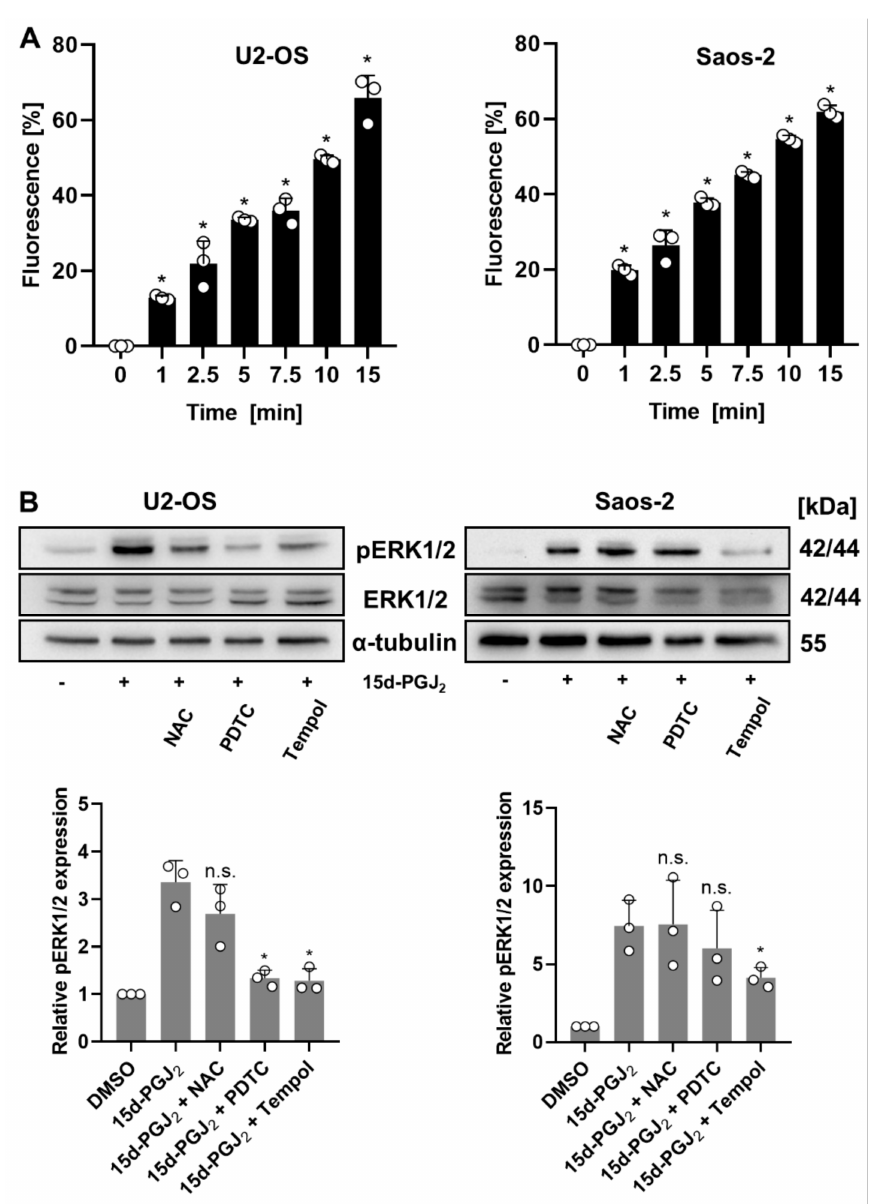
Figure 2. Induction of ROS production in OS cells treated with 15d-PGJ 2 . ( A ) Upon treat- ment of U2-OS ( left panel) and Saos-2 ( right panel) with 15d-PGJ 2 for indicated time peri- ods, OS cells were incubated with the ROS-reactive carboxy-H 2 DCFDA (5-(and -6)-carboxy-2 (cid:48) ,7 (cid:48) - dichlorodihydrofluorescein diacetate) dye. The resulting changes in fluorescence were measured and displayed as bar graph for each cell line. The data are represented as means ± SD (* p ≤ 0.05) from three independent experiments. ( B ) Following a 30 min pre-incubation with ROS inhibitors (NAC (N-acetyl-cysteine), 15 µ M; PDTC (pyrrolidine dithiocarbamate), 10 µ M; Tempol, 10 µ M), U2-OS ( left panel) and Saos-2 ( right panel) cells were exposed to the 20 µ M 15d-PGJ 2 for 15 min, followed by cell harvesting and lysis. The effects of the ROS inhibition on 15d-PGJ 2 -mediated intracellular MAPK activation (pERK1/2) were analyzed by immunoblotting experiments. One representative blot out of three is shown. Alpha-tubulin ( α -tubulin) was used as a loading control (upper panel). Densitometric evaluation (lower panel) was based on at least three independent experiments and put in correlation to pERK1/2 expression in 15d-PGJ 2 -treated cells. Means ± SD are shown. (* p ≤ 0.05; n.s. = not